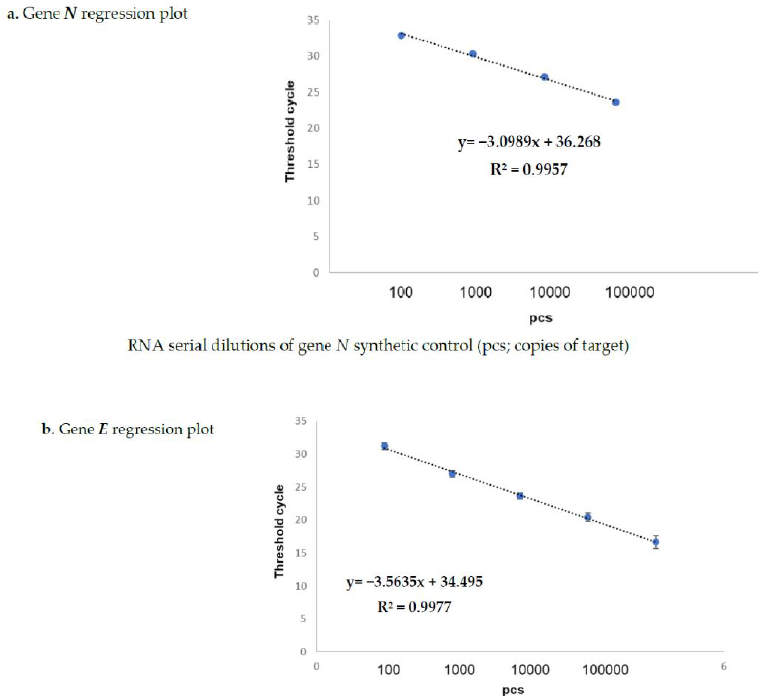
Figure 1. Spike-in of genes N ( a ) and E ( b ) evaluated by Kit-A. Figures ( a , b ) show the regression plots regarding the correlation curves obtained by the real-time TaqMan PCR Kit-A on serial dilutions of both synthetic positive control (pcs; copies of target) genea N and E . The starting volume of the input RNA for the reverse transcription and qPCR (one step process) was 5 µL for each target. The RNA amounts corresponding to each titration point amplified by one-step RT-qPCR were 0.1 pg, 1 pg,10 pg, 100 pg, and 1 ng for both the N and E genes, respectively. The reference sequences for the primers are reported in Table